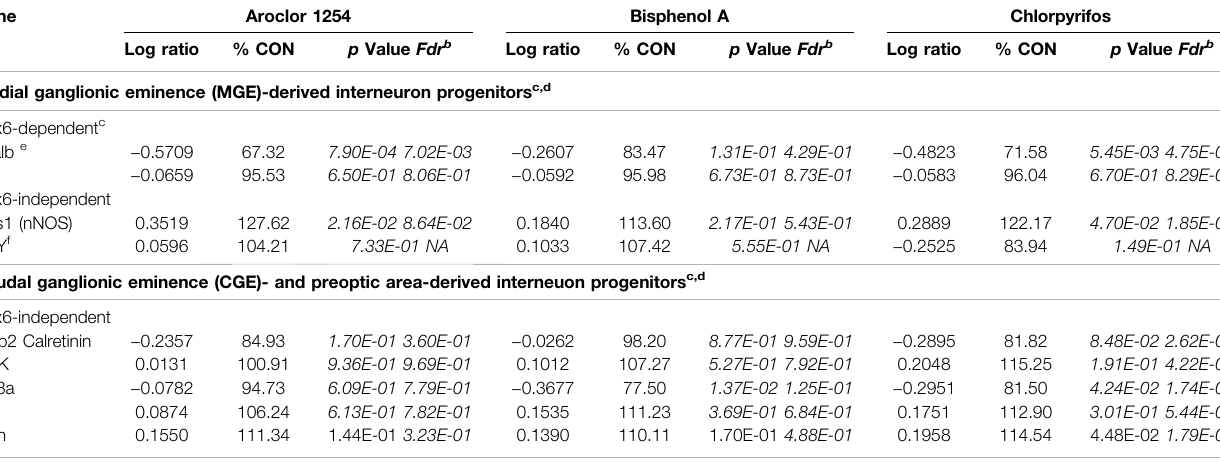
a Hippocampus of female offspring did not show signi fi cant changes in Pvalb, Sst, Nos1, NPY, Calb2, Htr3a, CCK, VIP, or Reln.